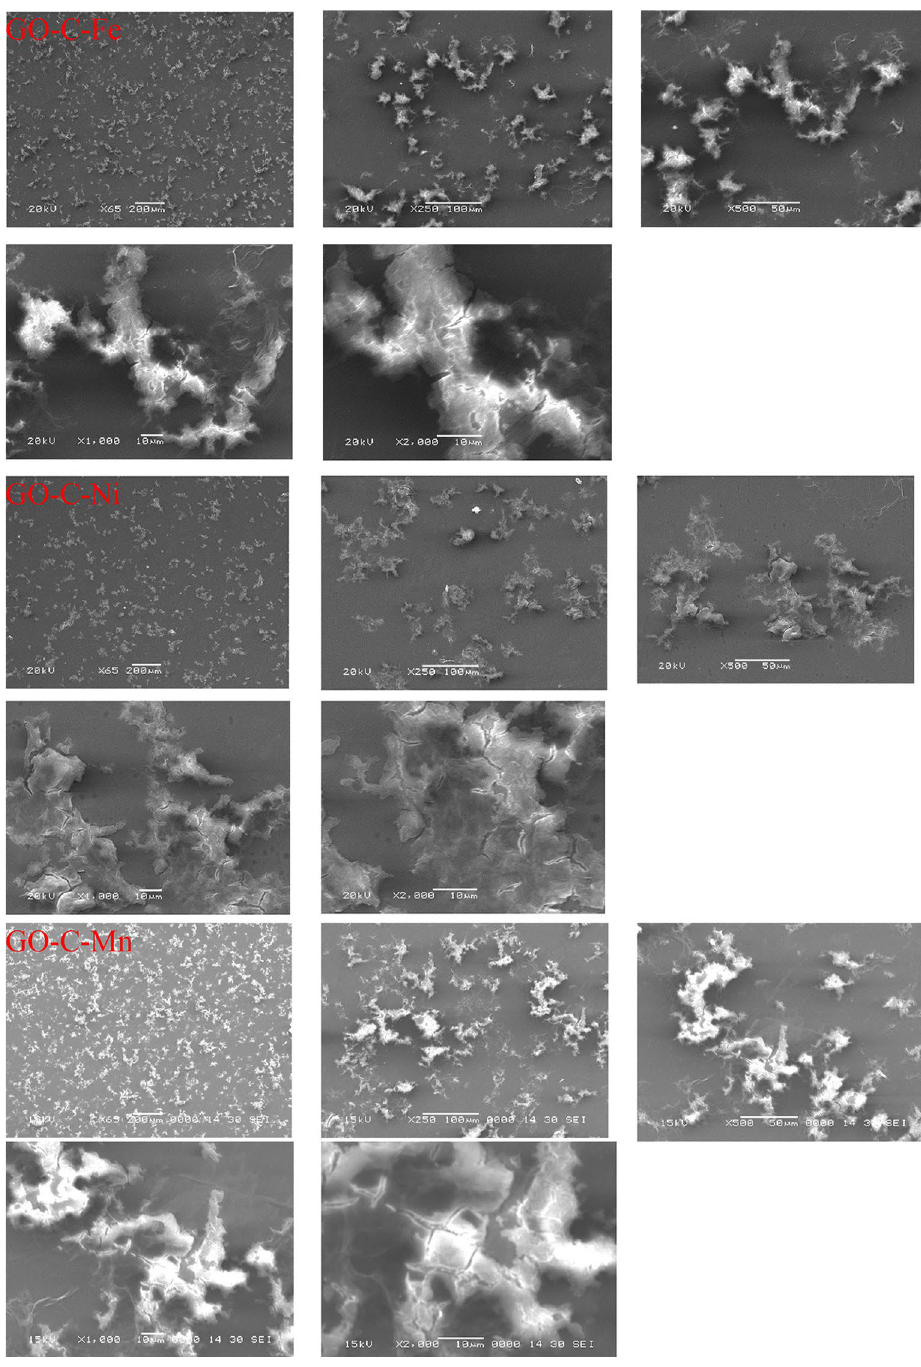
Figure 1. SEM images for GO-C-Fe complex, GO-C-Ni complex, and GO-C-Mn complex at different plotted in Fig. 4b. As indicated, the uptake percent of the studied metal ions (Fe 3+ , Ni 2+ , and Mn 2+ ) is linearly increased with the further increase in solution pH values. Accordingly, pH values 2.0 for Fe 3+ , 8.0 for Ni 2+ and 7.0 for Mn 2+ were chosen for further investigations. While the uptake percent for La 3+ and Nd 3+ did not exceed 2.0% at different pH values. Therefore, pH = 2.0 was chosen to optimize the purification of La(III) and Nd(III) from Fe(III), Ni(II), and Mn(II). As previously proposed 37 , the used GO-C composite contains three sodium carboxylate groups in the solid phase. In an aqueous solution at low pH, the sodium ions will exchange with the H + in the solution. This will form mono and diprotonated citrate on the surface of the composite. Based on the Medusa program (www. kemi. kth. se/ medusa), the speciation diagram for citric acid as a function of pH is given in Fig. S1. From this